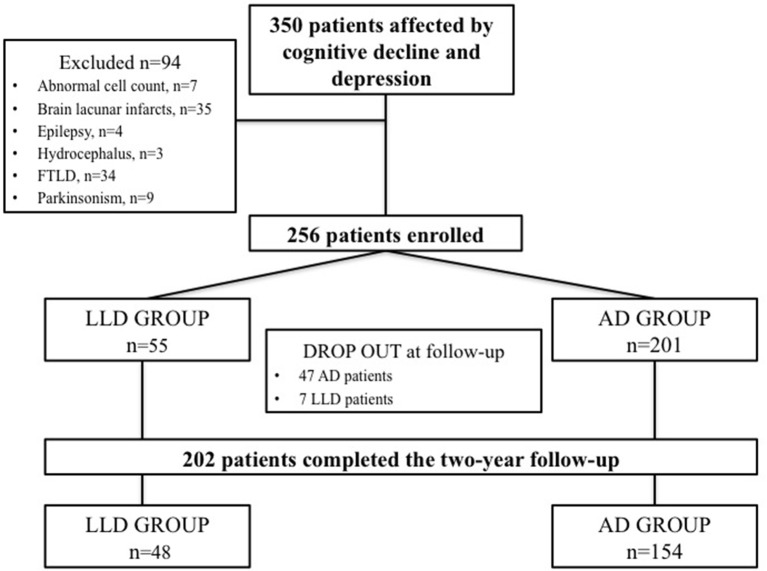
Flow-chart of the study.